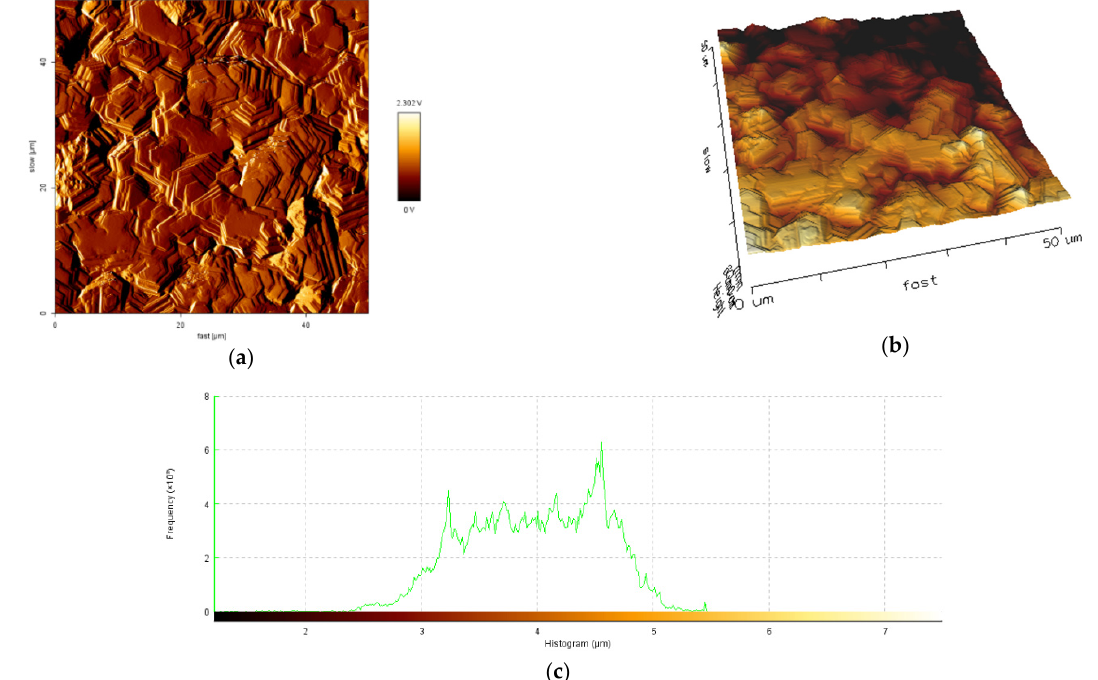
Figure 7. 50 × 50 μ m 2 AFM images of sample D: ( a ) 2D image; ( b ) 3D image; ( c ) histogram of the scanned surfaces. By increasing the current density for obtained hybrid coatings with mean diameter size of particles 0.1–5.0 μ m it could be observed that layers become uniform, with smaller grains, randomly orientated. By increasing the mean diameter size of polymer particles and maintaining current density at 40 mA/cm 2 it could be observed that the crystal grains are bigger, which in general leads to a surface roughness increase. The reinforcing particles